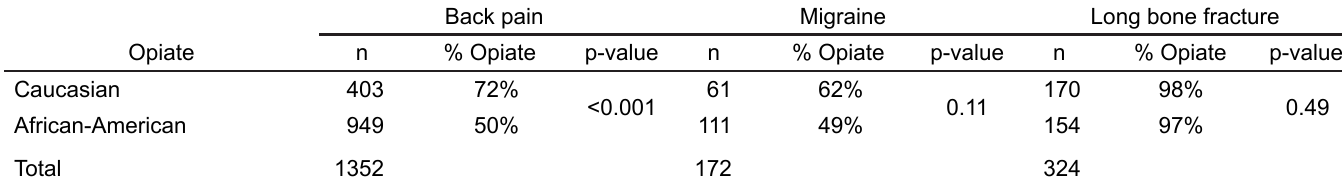
Table 3b. Percent of patients receiving opiate by diagnosis and